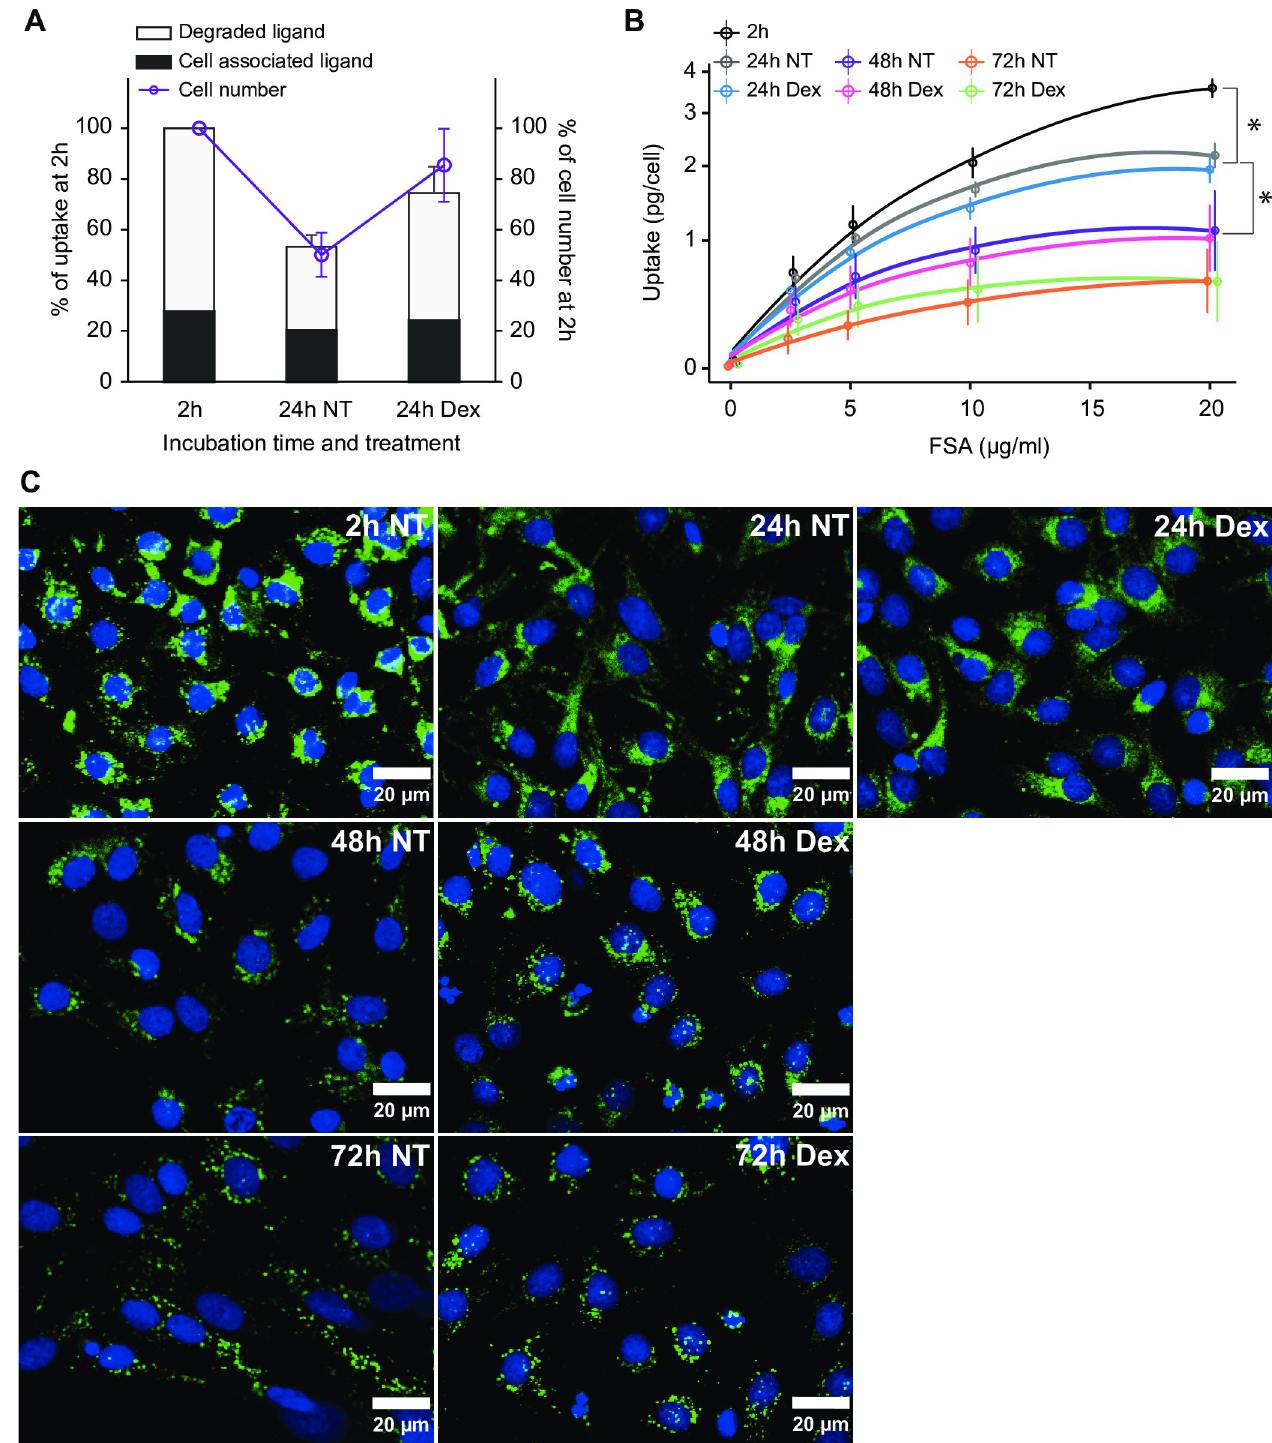
Fig 9. Effect of Dex on rat LSEC endocytosis in culture. (A) Endocytosis of trace amounts of 125 I-labeled formaldehyde-treated serum albumin ( 125 I-FSA) in primary LSEC cultures. The cells were cultured for 2 or 24 h ± Dex; then incubated with 0.1 μ g/ml 125 I-FSA for another 2 h. Ligand uptake per culture represents the sum of cell associated ligand (black part of bar), and degraded ligand in supernatant (grey part of bar) as described in Material and Methods. The total ligand uptake/culture was 67% (SD = 2.6%, n = 3) of added ligand in 2h cultures, and this is set as 100% in the figure, and uptake in the 24 h cultures given in % of this value. The number of adherent cells at 24 h post seeding is shown in % of the cell number at 2 h. The differences in uptake of 125 I-FSA